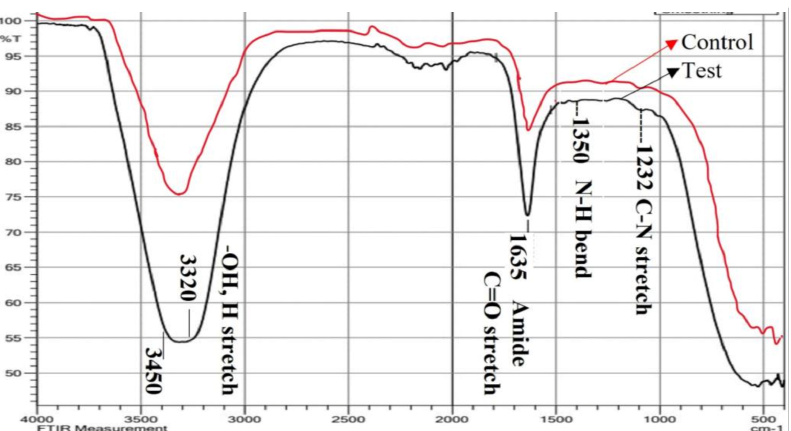
Figure 6. FTIR spectrum of bacterial supernatant-synthesized silver nanoparticles (test sample) in comparison with control (bacterial supernatant). Quite a few peaks denoting the functional groups of biologically active compounds were obtained in a range of 4000–400 cm − 1 on a